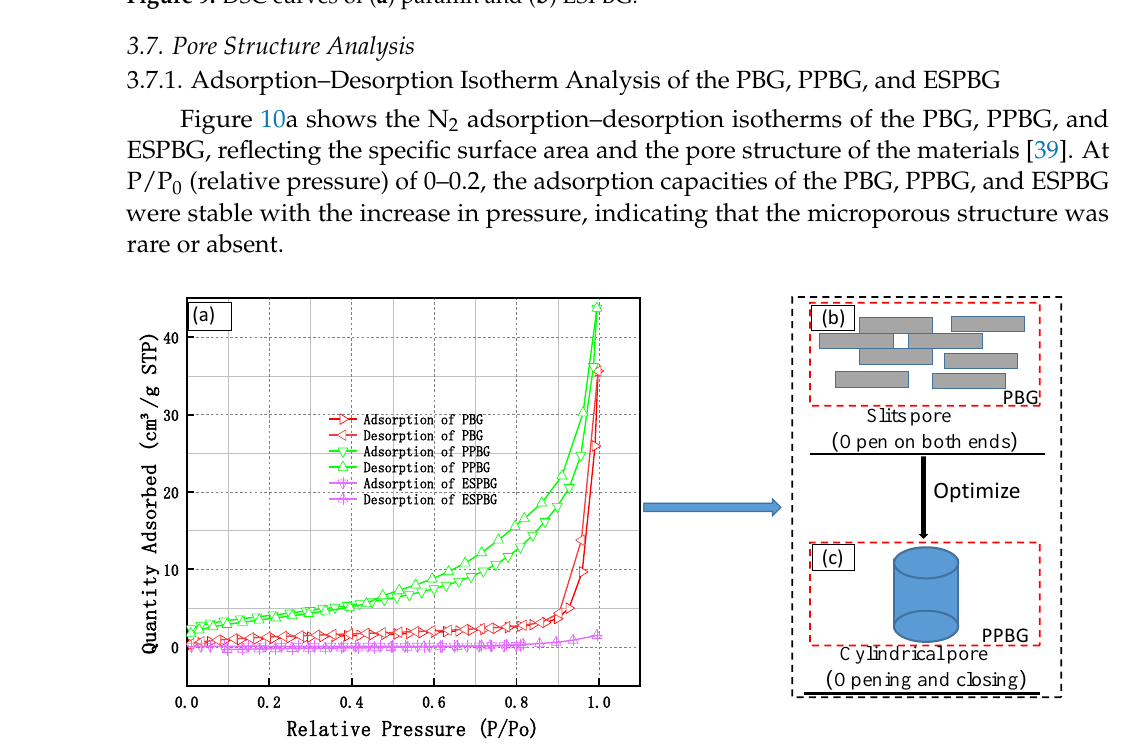
Figure 10. ( a ) Adsorption isotherm curves of the PBG, PPBG, and ESPBG; ( b ) PBG slits pore; ( c ) PPBG cylindrical pore.